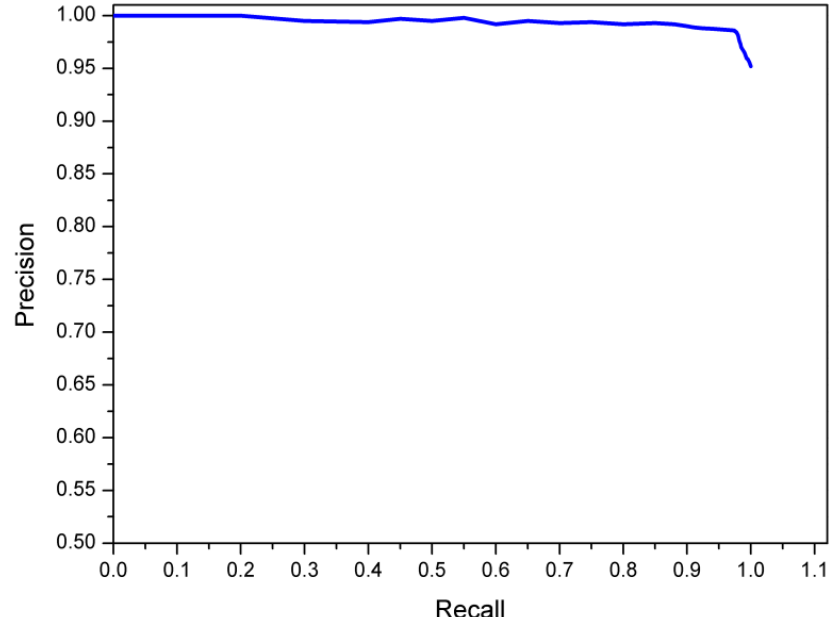
Figure 2. The P-R curve of the model.